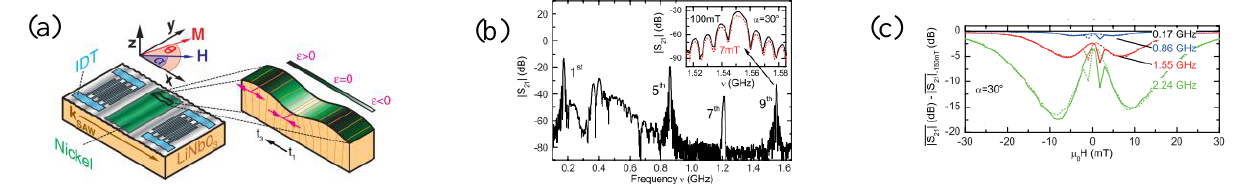
Figure 10. (a) Illustration of experimental setup; (b) S 21 of the device as function of frequency when 604 Figure 10. ( a ) Illustration of experimental setup; ( b ) S 21 of the device as function of frequency when 𝐻 = 0 and inset focused on the influence of external magnetic field H on the 9 th harmonic; (c) S 21 605 H = 0 and inset focused on the influence of external magnetic field H on the 9th harmonic; ( c ) S 21 as as function of H for several resonance modes, adapted with permission from [148]. function of H for several resonance modes, adapted with permission from